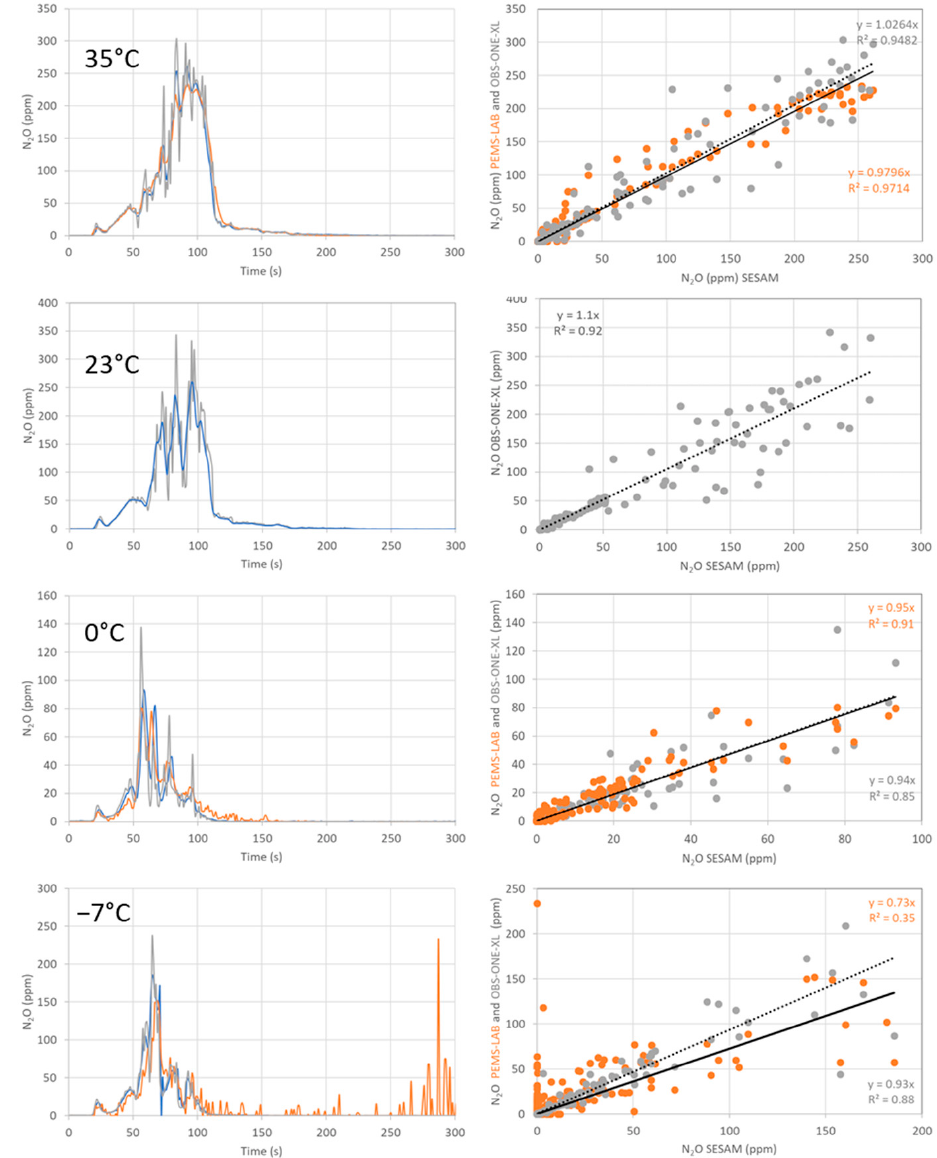
Figure 3. ( Left panels ) N 2 O emission profiles measured using the SESAM (blue), PEMS-LAB (orange) and OBS-ONE-XL (grey) over the first 300 s of WHVC at 35 °C, 23 °C, 0 °C and − 7 °C. ( Right panels ) Correlation of the N 2 O concentrations measured by the SESAM plotted against the N 2 O concentrations measured by the PEMS-LAB (orange) and against the OBS-ONE-XL (grey). The PEMS-LAB’s trend line is represented by a solid black line and the OBS-ONE-XL’s trend line is represented by a dashed black line.